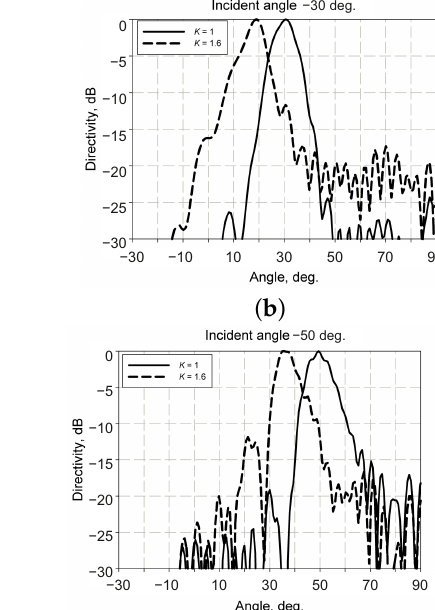
Figure 9. Simulated radiation patterns at different incident angles from ( a ) ( d ) 50 deg. for indoor implementation of the reflector operating at 60GHz. − Table 1. The simulation results of the deflection angle. Angle of Incidence, deg